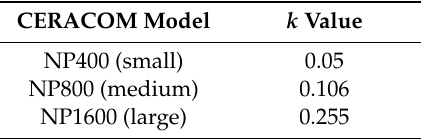
Table 3. Multification factor for di ff erent size of CERACOM PAR.